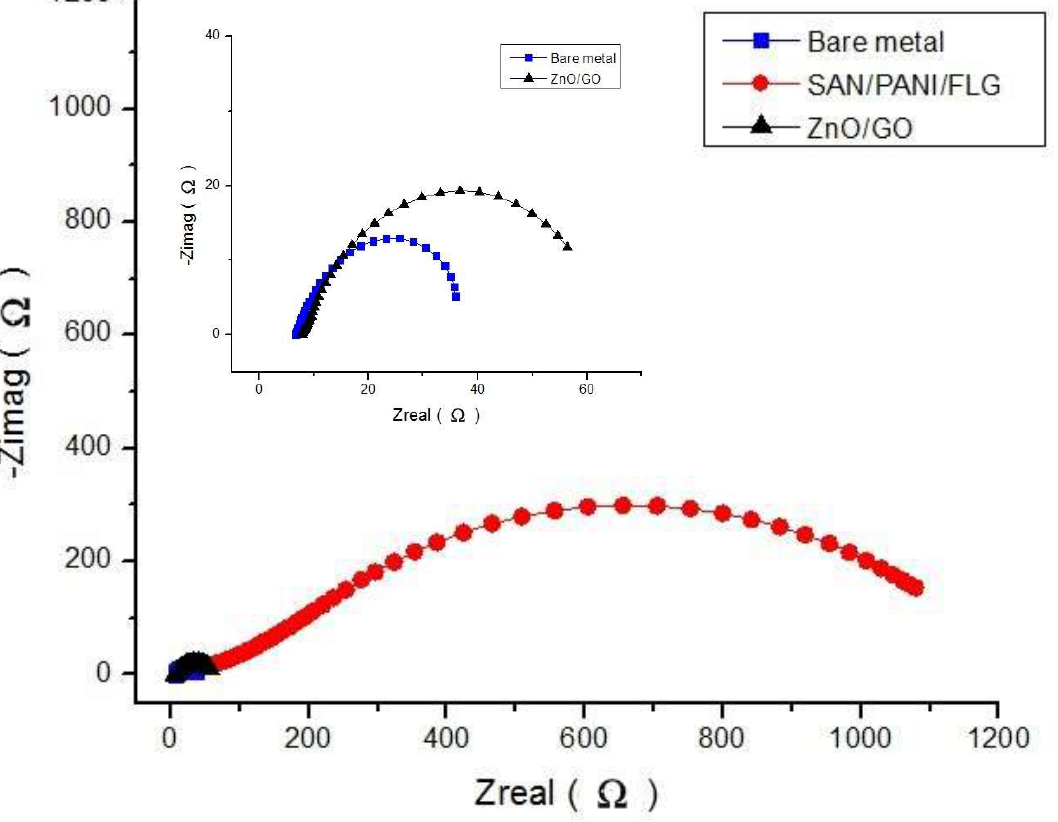
Figure 8. Comparison of Nyquist Plot (crude oil produced water).